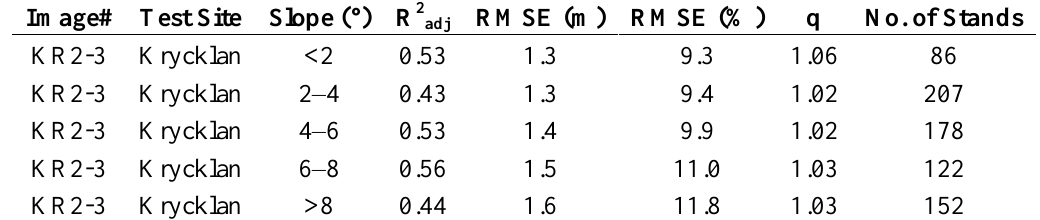
Table 10. Slope class results of H at